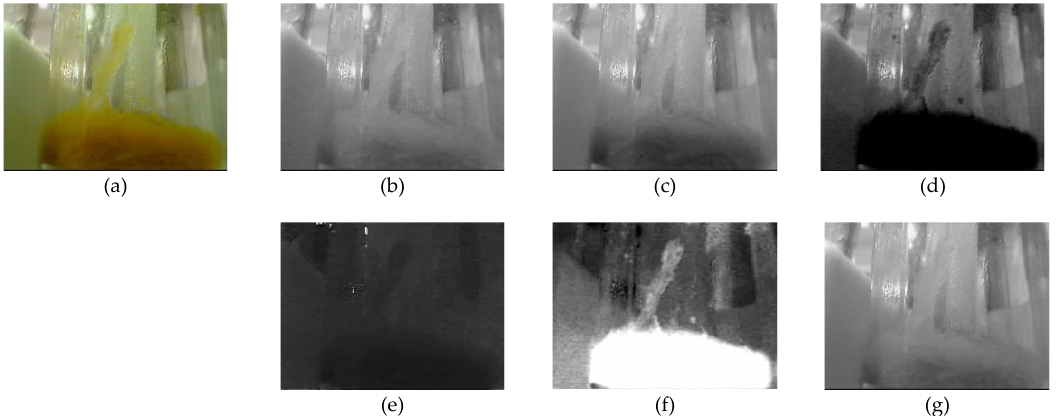
Figure 3. The grayscale maps in different color channels. ( a ) Represents the original image; ( b )–( g ) represent the red, green, blue, hue, saturation, and value channels, respectively.